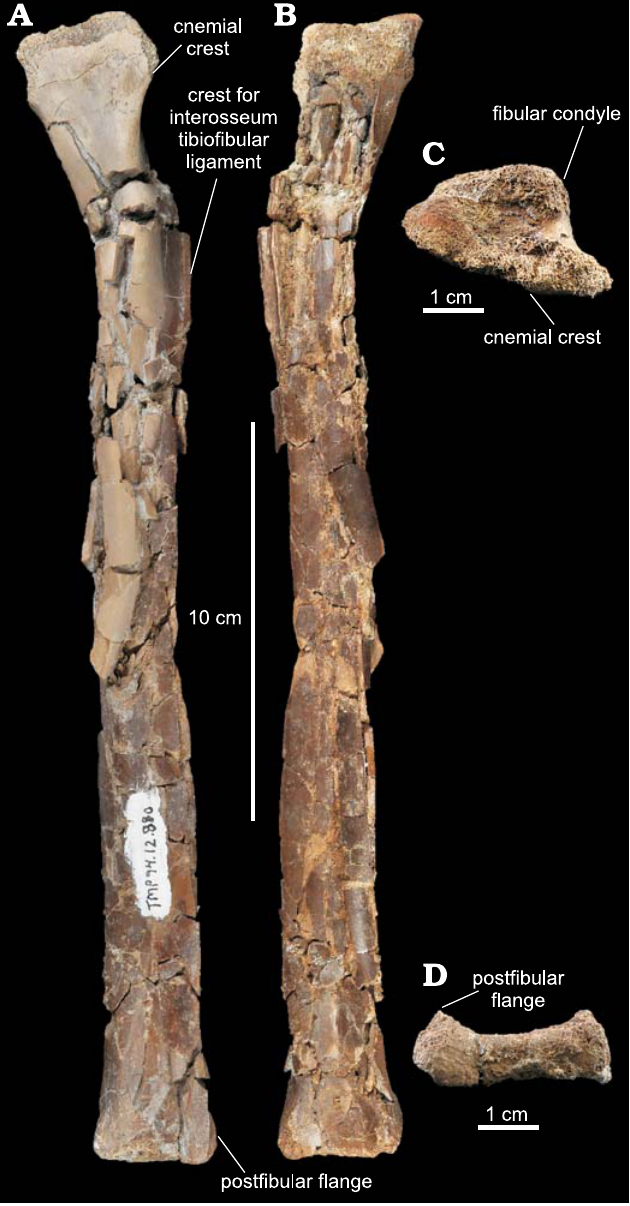
Fig. 1. Elmisaurine dinosaur Leptorhynchos elegans (Parks, 1933) (TMP 1994.012.0880) from the Upper Campanian Dinosaur Park Formation, Dinosaur Provincial Park, Alberta, Canada. Left tibia in anterior ( A ), pos- terior ( B ), proximal ( C ), and distal ( D ) views.